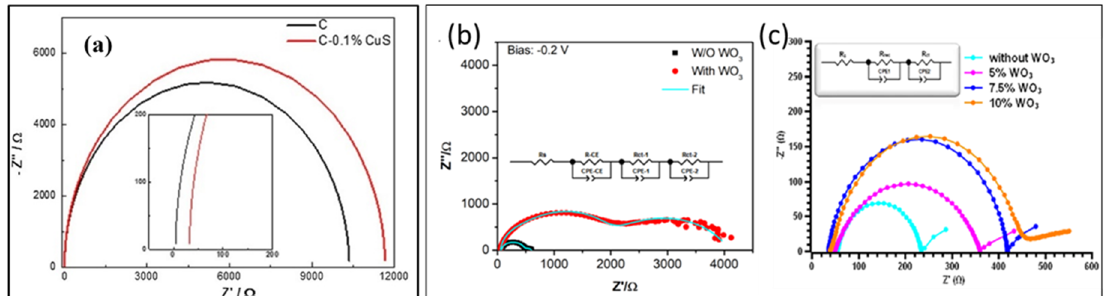
Figure 11. Nyquist plots of carbon counter electrode-based HTM-free PSC: ( a ) without and with 0.1% CuS incorporated carbon-based HTM-free PSCs (Reproduced with permission from [76]. Elsevier, 2018.); and ( b , c ) without WO 3 additive and with WO 3 additive. ( b ) Reproduced with permission from [44]. Royal Society of Chemistry, 2014. ( c ) Reproduced with permission from [29]. American Chemical Society, 2020.